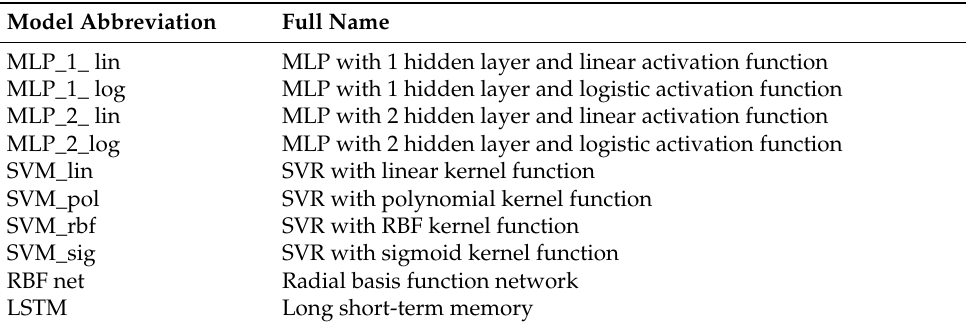
Table 4. Abbreviation of ten intelligent forecast